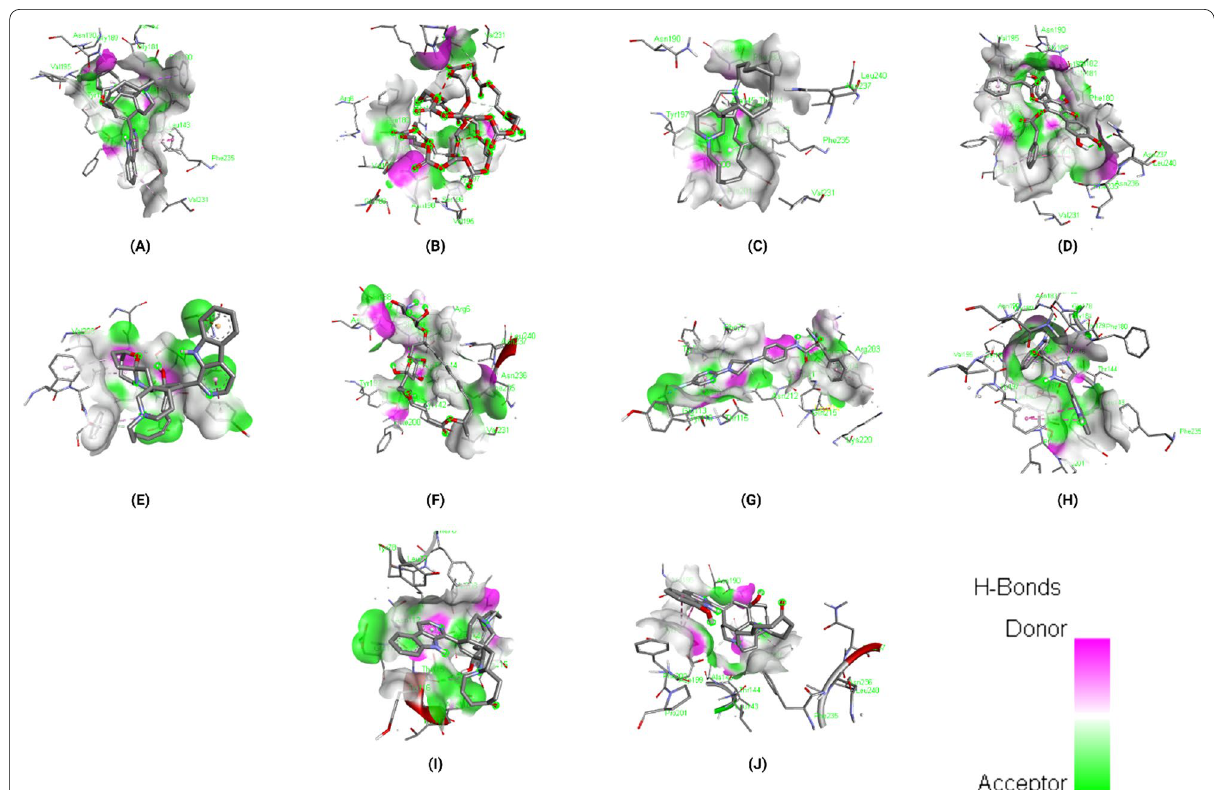
Fig. 6 3D visualisation of docking analysis of CotH3 binding with 12,28-oxamanzamine A ( a ), parsiguine ( b ), haliclonacyclamine B ( c ), vialinin B ( d ), 6-deoxymanzamine X ( e ), natamycin ( f ), olorofim ( g ), deoxytopsentin ( h ), manzamine E ( i ), fascioquinol A ( j